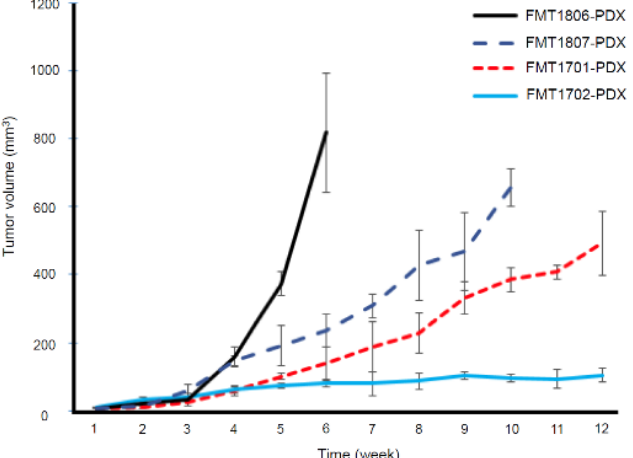
Figure 1. Histological examples of FMT PDXs. H&E staining was used to assess tumor structure of original patient samples